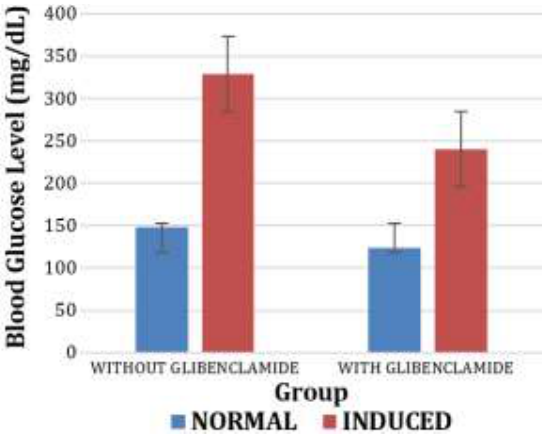
Figure 1. Hypoglycemic Effect of Glibenclamide in Normal and Induced